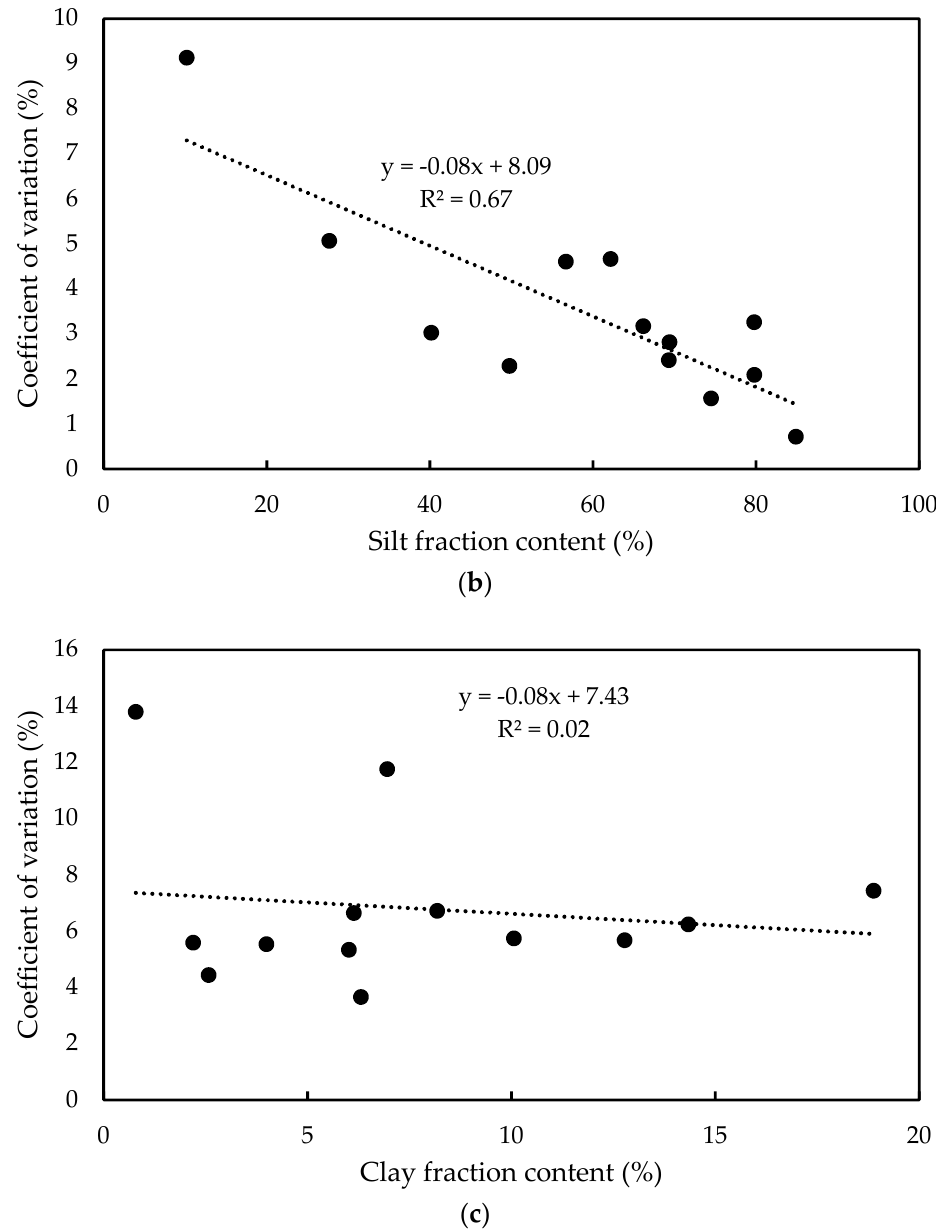
Figure 3. Relationship between coefficient of variation and individual fraction contents: ( a )—sand; ( b )—silt; ( c )—clay. The relationship between sand fraction content and CV was well described by the power function. The highest values of CV were obtained for samples containing a very small amount of sand particles, i.e., about 1%. The higher the sand fraction content, the lower the scattering of the results. Interpolation by straight line was a better approximation for describing the analogous relationship for the silt fraction. The trend was the same (i.e., the larger the amount of fraction content, the smaller the scattering of results) but the decrease was not so rapid. There was no visible trend in the case of clay fraction content. Although for the smallest clay fraction content, the CV value was the largest (about 14%), for the other clay contents, the scattering of CV values was rather